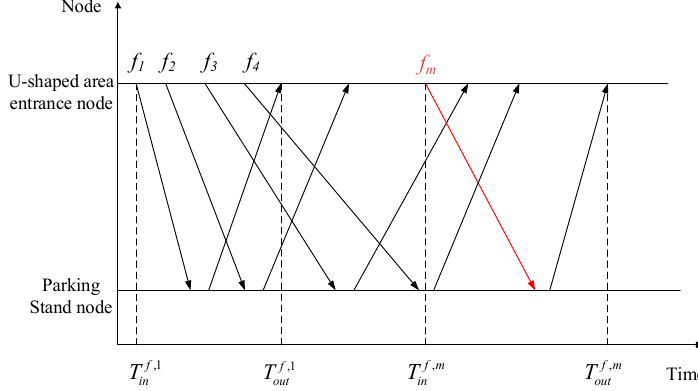
Figure 8. Macroscopic Distribution Network of U-shaped Area.